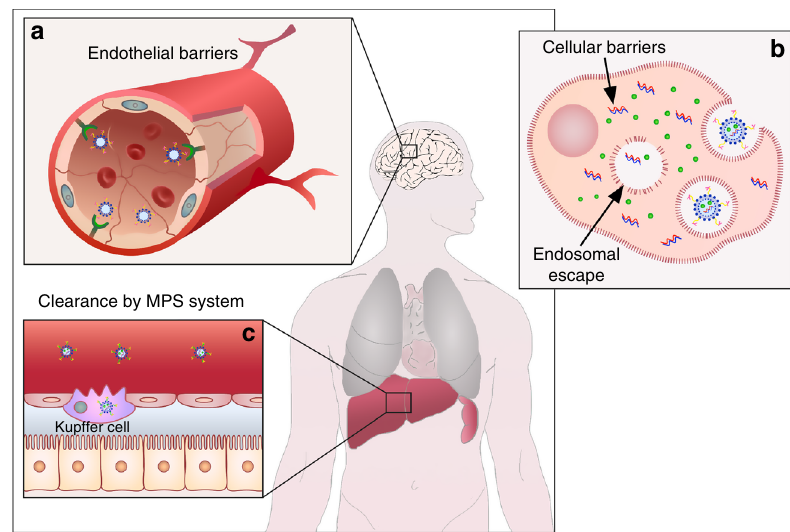
Fig. 1 Schematic illustration of main physiological barriers faced by passive and active targeted NCs. a NCs face endothelial barriers in the process of their extravasation into the tumor tissue; illustration of the blood – brain barrier as an example. b Uptake of NCs by the target cells and their escape from the endo-lysosomal system into the cytotosl are the major cellular barriers. c Hepatic Kupffer cells as an example of mononuclear phagocytic system (MPS), which results in the clearence of systemically administered NCs, reducing their half-life and effective